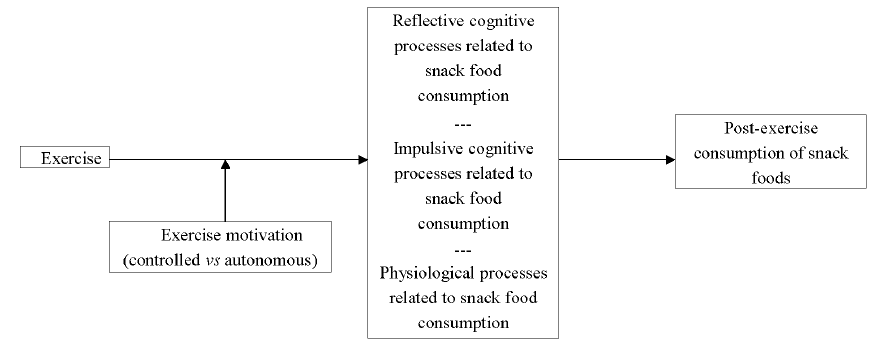
Figure 1. Hypothesized relationships between exercise, exercise motivation, and post-exercise consumption of pleasurable but unhealthy